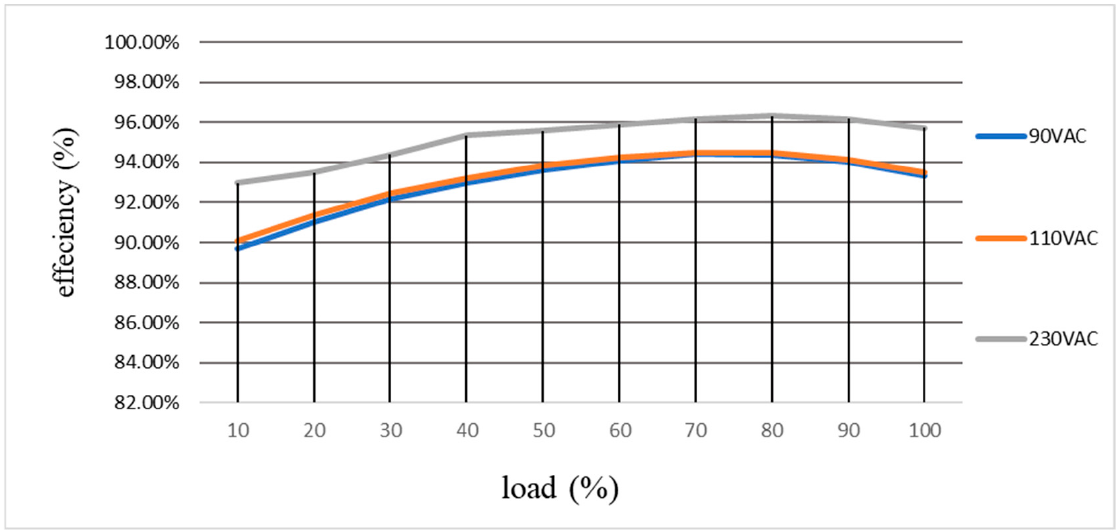
Figure 12. Plots of conversion efficiency of the proposed interleaving boost converter from light load to heavy load under the different input voltages. Table 3. Key component parameters of the proposed converter.